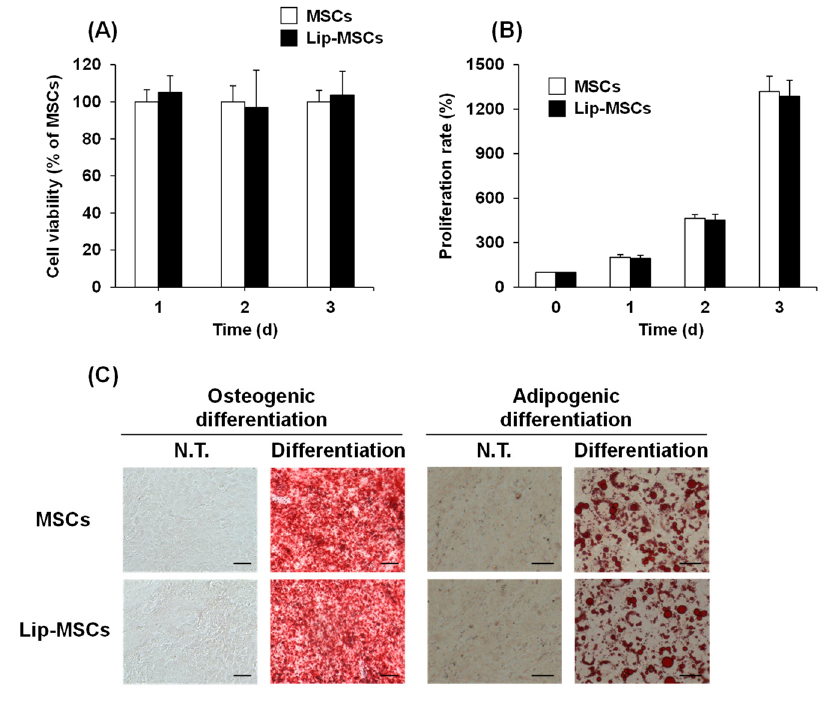
Figure 4. Cell viability, proliferation rate, and differentiation potential of Lip-MSCs. Non-loaded MSCs or Lip-MSCs were seeded in 24-well culture plates or 35 mm culture dishes, and cell viability ( A ) and the number of cells ( B ) were measured daily for 3 d. ( C ) The cells were incubated in osteo- genic differentiation medium or adipogenic differentiation medium for 3 weeks. The osteogenic or adipogenic differentiated cells were stained using alizarin red S or Oil red O, respectively. Scale bar: 50 µm. N.T.: